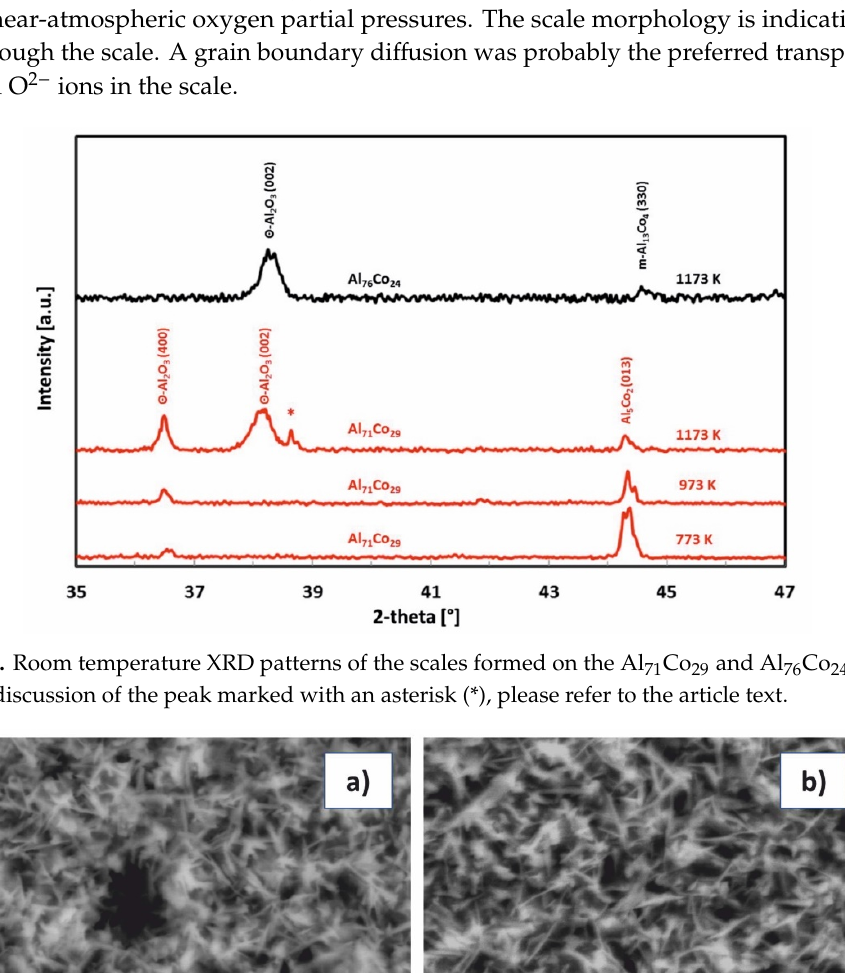
Figure 7. Blade-like morphology of alumina scale formed on the oxidized Al 71 Co 29 alloy ( a ) and Al 76 Co 24 alloy ( b ) during oxidation at 1173 K.